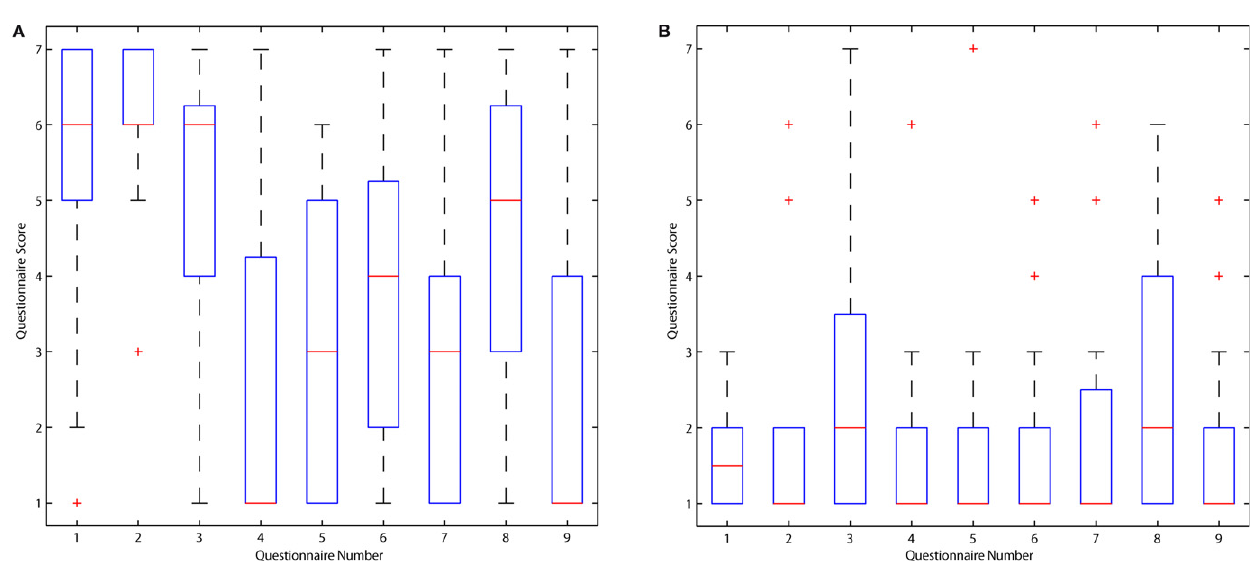
Figure 2 | Boxplots for the questionnaire responses in the two conditions. (A) Synchronous condition. (B) Asynchronous condition. Questions 1, 2 and 3 address the illusory experience. The medians are shown as red lines, and the boxes are the interquartile ranges (IQR). The whiskers represent either the extreme data points or extend to 1.5 × IQR. If there are values outside the whiskers these are conventionally called ‘outliers’, and are shown by ( +